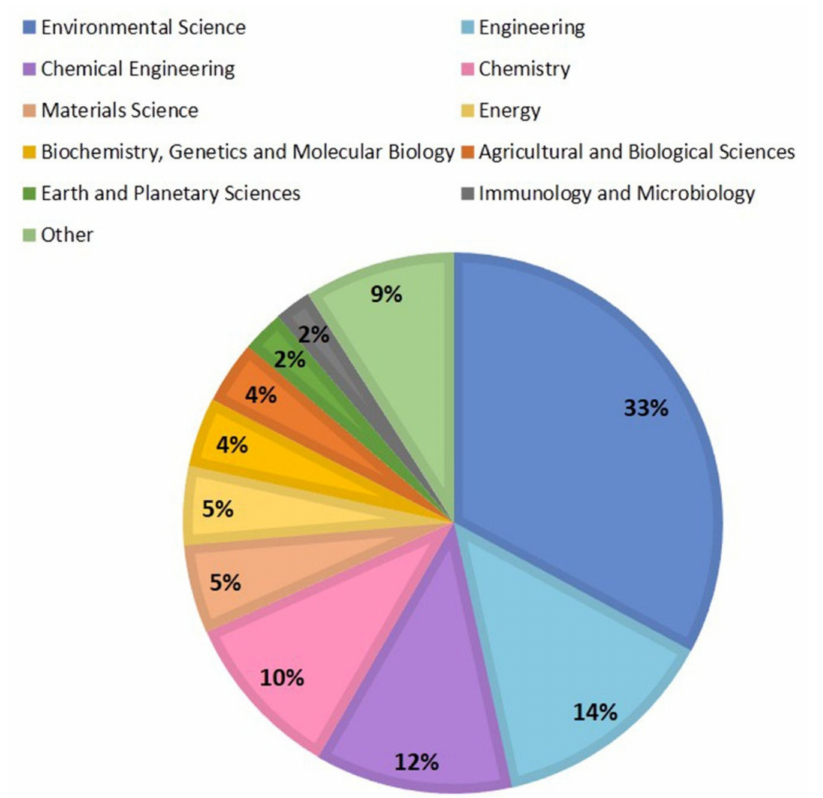
Figure 2. Thematic areas of publications in the field of wastewater treatment according to the Scopus